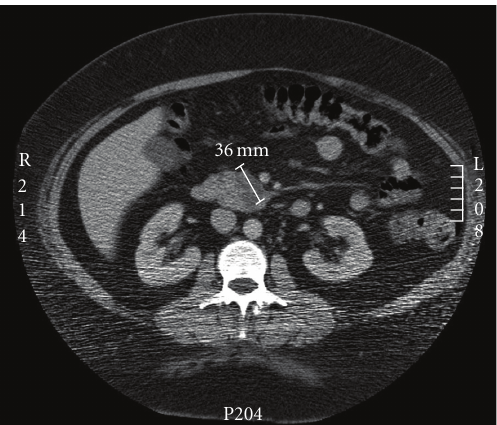
Figure 2: CT scan of the abdomen showing a 3.6 × 2.4cm cystic lesionwithin the uncinate process of the pancreas extending into the pancreatic